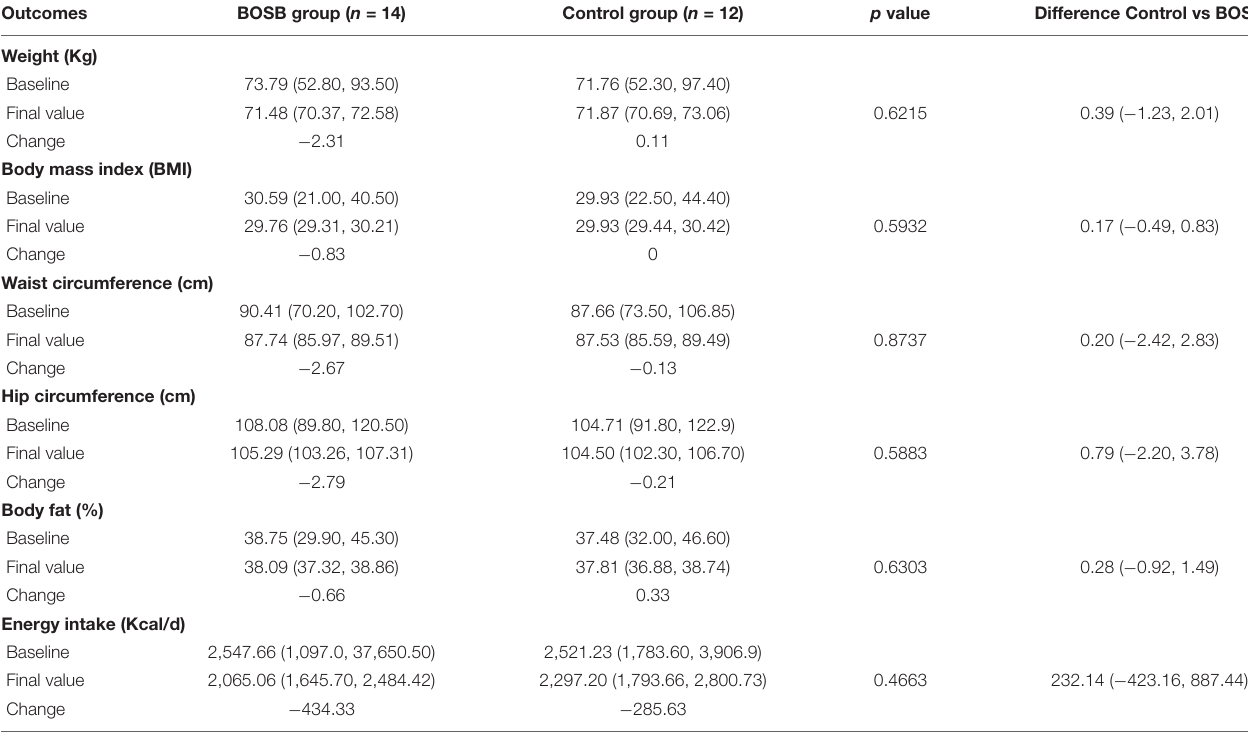
TABLE 3 | Changes in anthropometric measurements after 8-week consumption of BOSB. Outcomes BOSB group ( n = 14) Control group ( n = 12) p value Difference Control vs